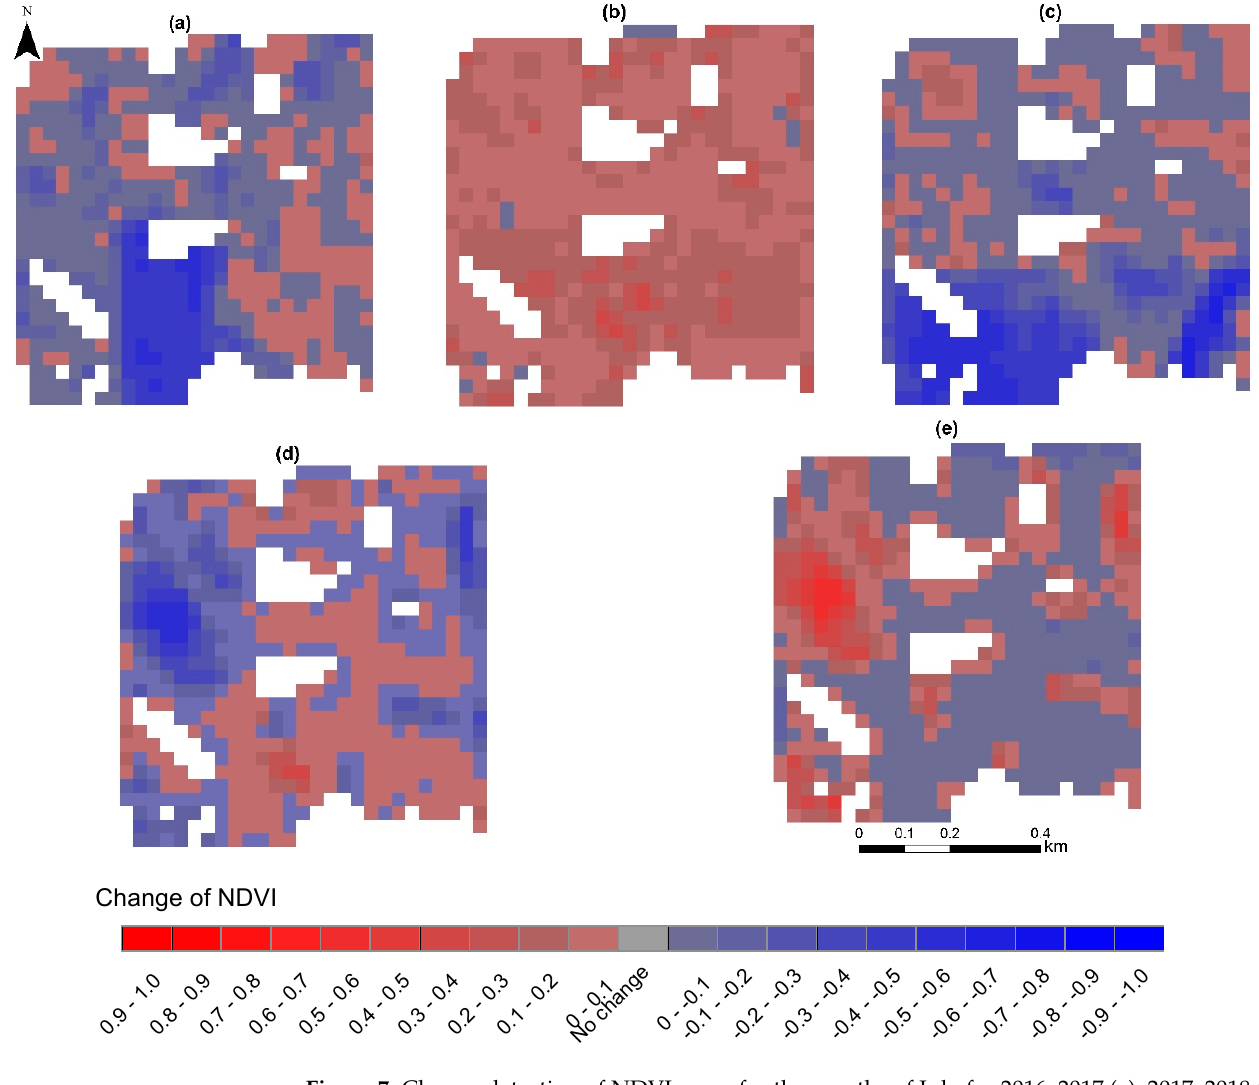
Figure 7. Change detection of NDVI maps for the months of July for 2016–2017 ( a ), 2017–2018 ( b ),